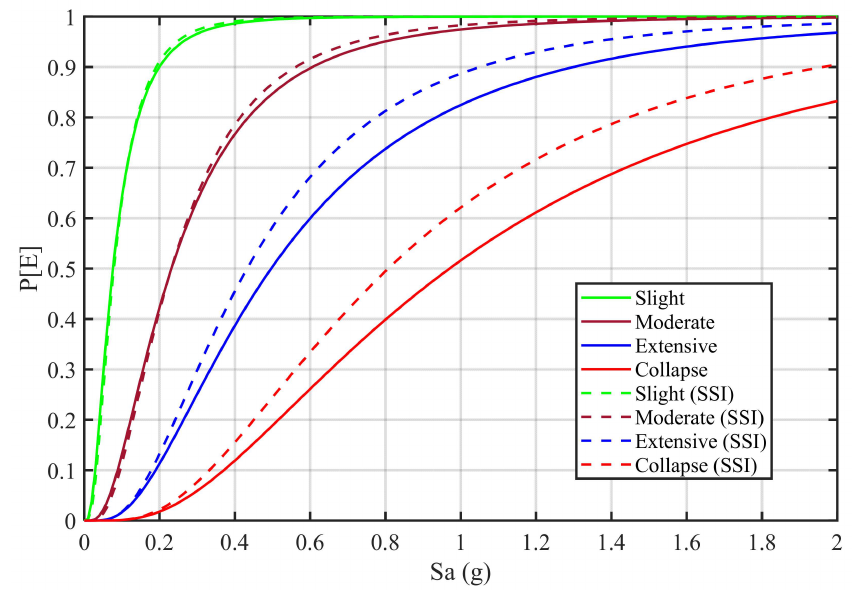
Figure 6. Fragility functions for RC elevated water tanks with smooth bars with and without considering soil structure interaction for full reservoir